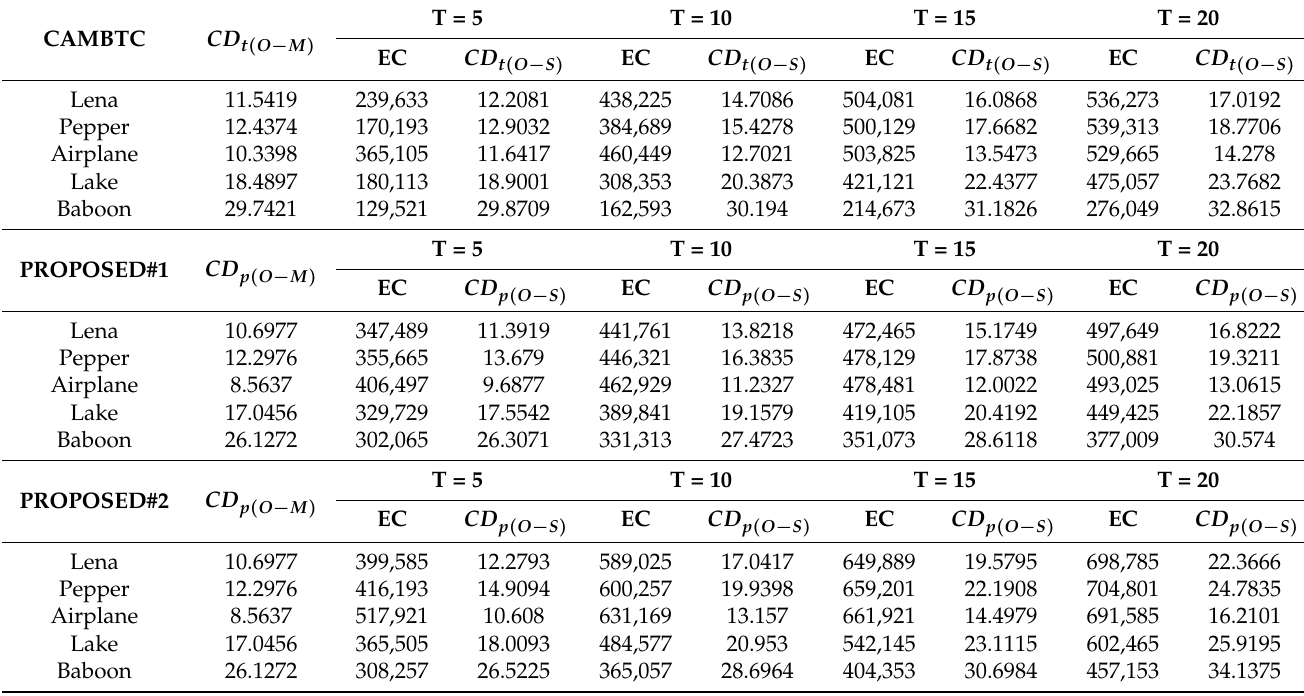
Table 2. Comparison of CD between the original image and marked image according to the threshold T